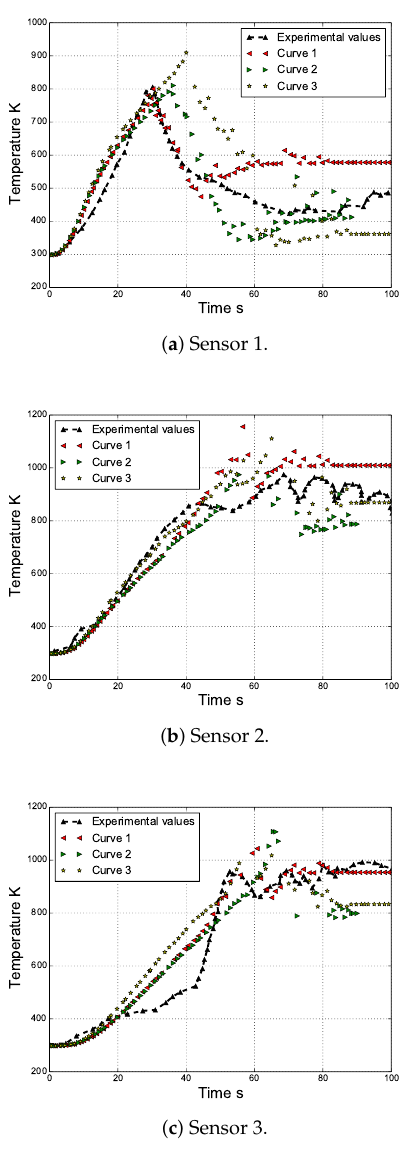
Figure 6. Temperature evolution for sensors 1, 2, and 3.